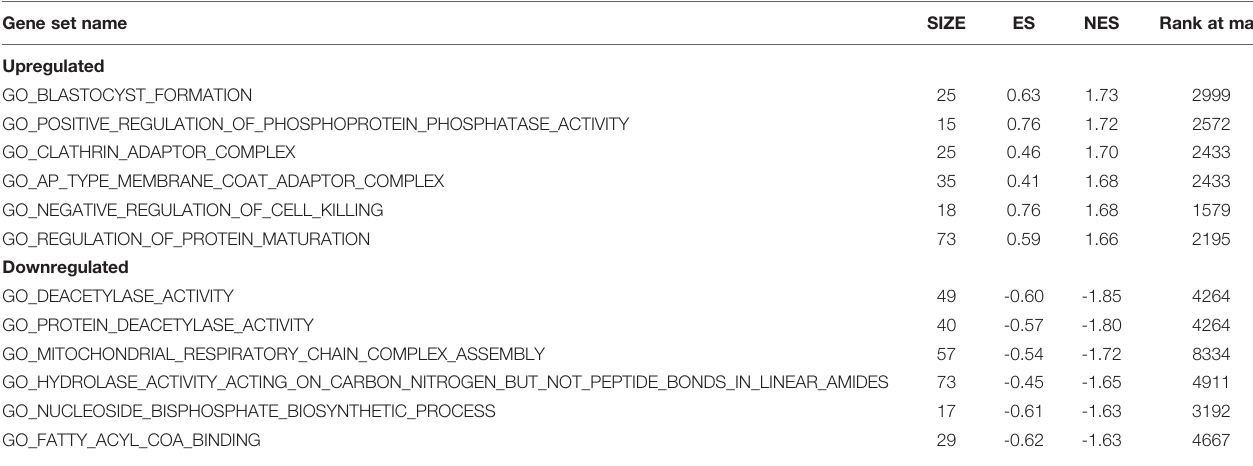
TABLE 2 | Functional enrichment analysis of DEGs in gastric cancer using GSEA.